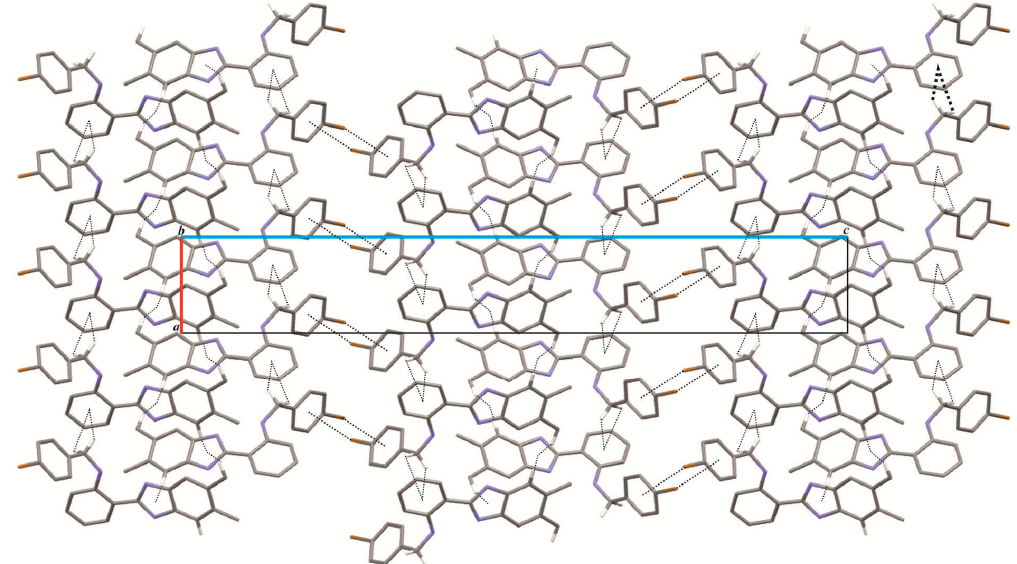
Figure 2. The arrangement of molecules in the crystal of 15 , viewed along the b -direction. The H-atoms not involved in the intermolecular interactions have been omitted for clarity. The C–H··· π and the C–Br··· π short contacts are represented by dotted lines.